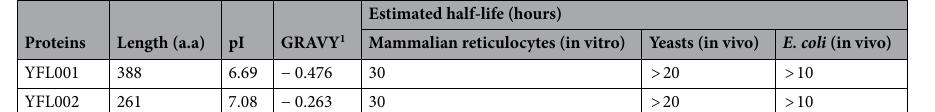
Table 2. Physicochemical properties of the proteins by ProtParam. 1 Grand average of hydropathicity.